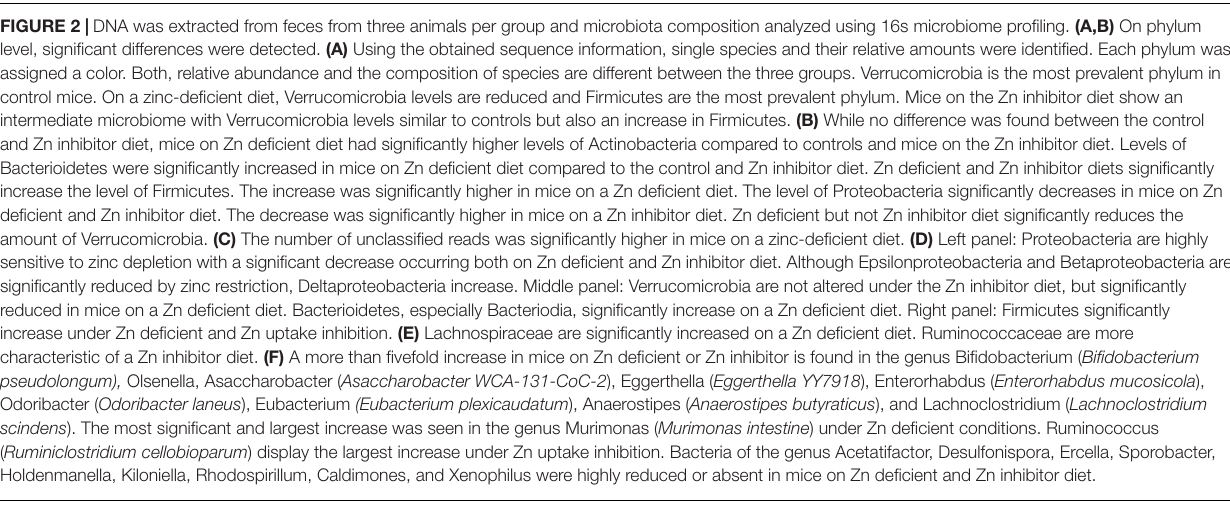
FIGURE 2 | DNA was extracted from feces from three animals per group and microbiota composition analyzed using 16s microbiome profiling. (A,B) On phylum level, significant differences were detected. (A) Using the obtained sequence information, single species and their relative amounts were identified. Each phylum was assigned a color. Both, relative abundance and the composition of species are different between the three groups. Verrucomicrobia is the most prevalent phylum in control mice. On a zinc-deficient diet, Verrucomicrobia levels are reduced and Firmicutes are the most prevalent phylum. Mice on the Zn inhibitor diet show an intermediate microbiome with Verrucomicrobia levels similar to controls but also an increase in Firmicutes. (B) While no difference was found between the control and Zn inhibitor diet, mice on Zn deficient diet had significantly higher levels of Actinobacteria compared to controls and mice on the Zn inhibitor diet. Levels of Bacterioidetes were significantly increased in mice on Zn deficient diet compared to the control and Zn inhibitor diet. Zn deficient and Zn inhibitor diets significantly increase the level of Firmicutes. The increase was significantly higher in mice on a Zn deficient diet. The level of Proteobacteria significantly decreases in mice on Zn deficient and Zn inhibitor diet. The decrease was significantly higher in mice on a Zn inhibitor diet. Zn deficient but not Zn inhibitor diet significantly reduces the amount of Verrucomicrobia. (C) The number of unclassified reads was significantly higher in mice on a zinc-deficient diet. (D) Left panel: Proteobacteria are highly sensitive to zinc depletion with a significant decrease occurring both on Zn deficient and Zn inhibitor diet. Although Epsilonproteobacteria and Betaproteobacteria are significantly reduced by zinc restriction, Deltaproteobacteria increase. Middle panel: Verrucomicrobia are not altered under the Zn inhibitor diet, but significantly reduced in mice on a Zn deficient diet. Bacterioidetes, especially Bacteriodia, significantly increase on a Zn deficient diet. Right panel: Firmicutes significantly increase under Zn deficient and Zn uptake inhibition. (E) Lachnospiraceae are significantly increased on a Zn deficient diet. Ruminococcaceae are more characteristic of a Zn inhibitor diet. (F) A more than fivefold increase in mice on Zn deficient or Zn inhibitor is found in the genus Bifidobacterium ( Bifidobacterium pseudolongum), Olsenella, Asaccharobacter ( Asaccharobacter WCA-131-CoC-2 ), Eggerthella ( Eggerthella YY7918 ), Enterorhabdus ( Enterorhabdus mucosicola